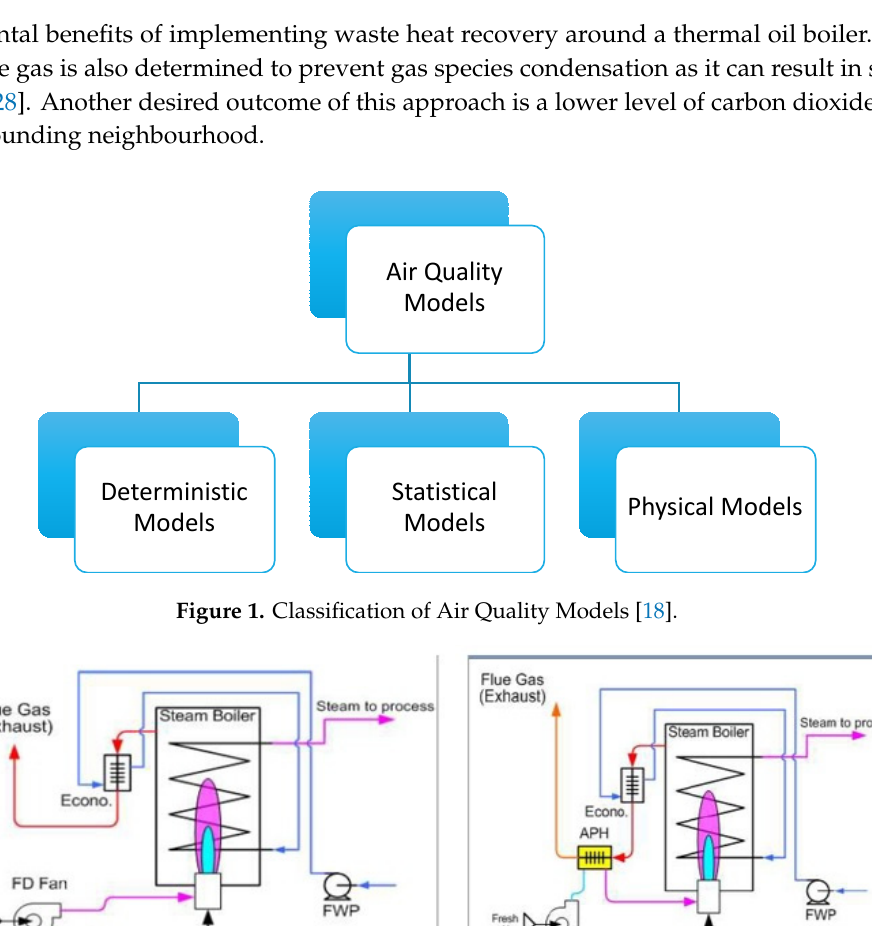
Figure 1. Classification of Air Quality Models [18].